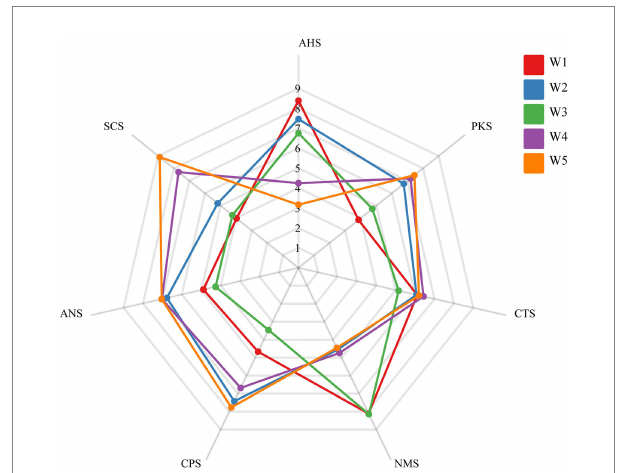
FIGURE 1 Radar charts of the taste profiles of Longjing tea infusions with different withering degrees, presented using responses of electronic tongue sensors. Tea samples with different withering degrees (the actual measured moisture contents at 75.05, 72.53, 70.07, 68.00, and 64.78%) were expressed as W1, W2, W3, W4, and W5.